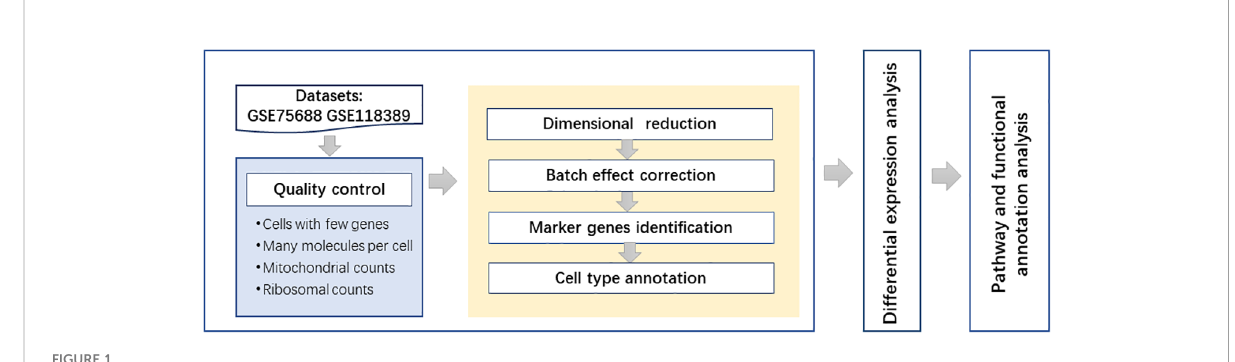
FIGURE 1 The fl owchart of the overall